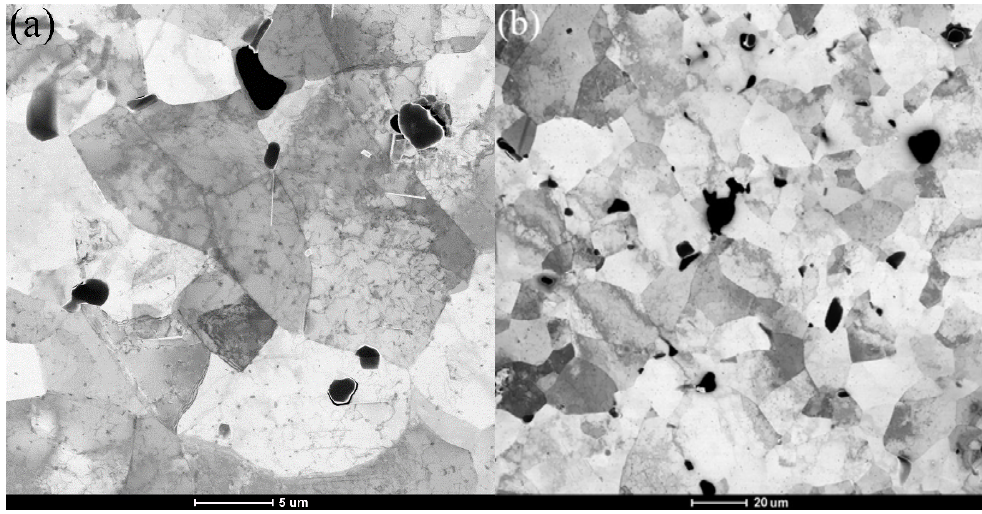
Figure 2. The Transmission Electron Microscope images of homogenized (before CECC process) 6061 aluminum alloy observed with different magnification. ( a ) 5 ( μ m); ( b ) 20 ( μ m).